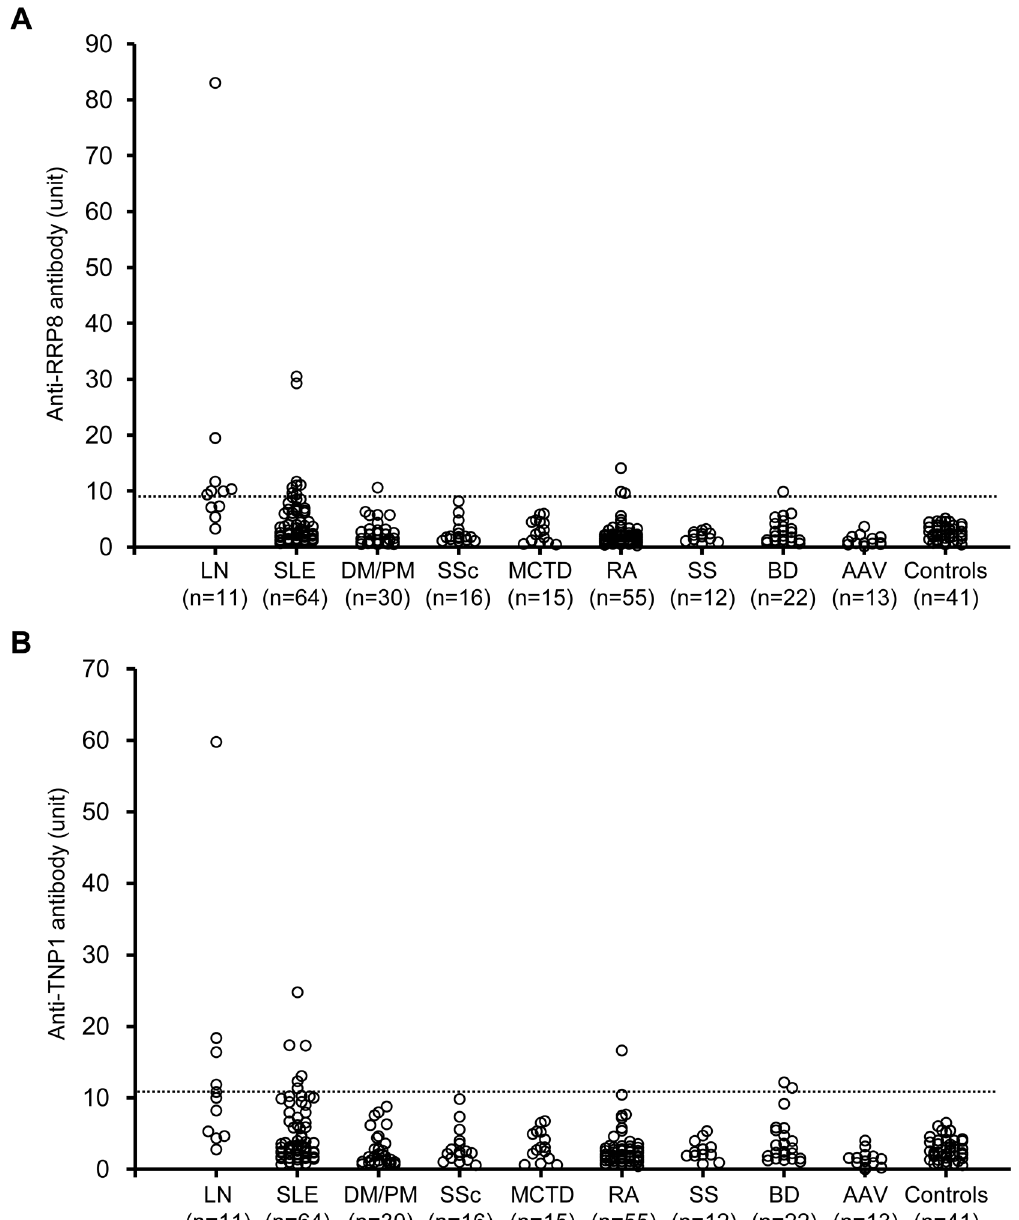
Fig 3. Serum levels of anti-RRP8 (A) and anti-TNP1 (B) antibodies in patients with rheumatic diseases. Cut-off values for positivity (9.1 units for anti- RRP8 antibody and 10.6 units for anti-TNP1 antibody) are indicated by the dotted lines. LN, lupus nephrits; SLE, systemic lupus erythematosus without LN; DM, dermatomyositis; PM, polymyositis; SSc, systemic sclerosis; MCTD, mixed connective tissue disease; RA, rheumatoid arthritis; SS, Sjögren syndrome; BD, Behçet ’ s disease; AAV, anti-neutrophil cytoplasmic antibody-associated